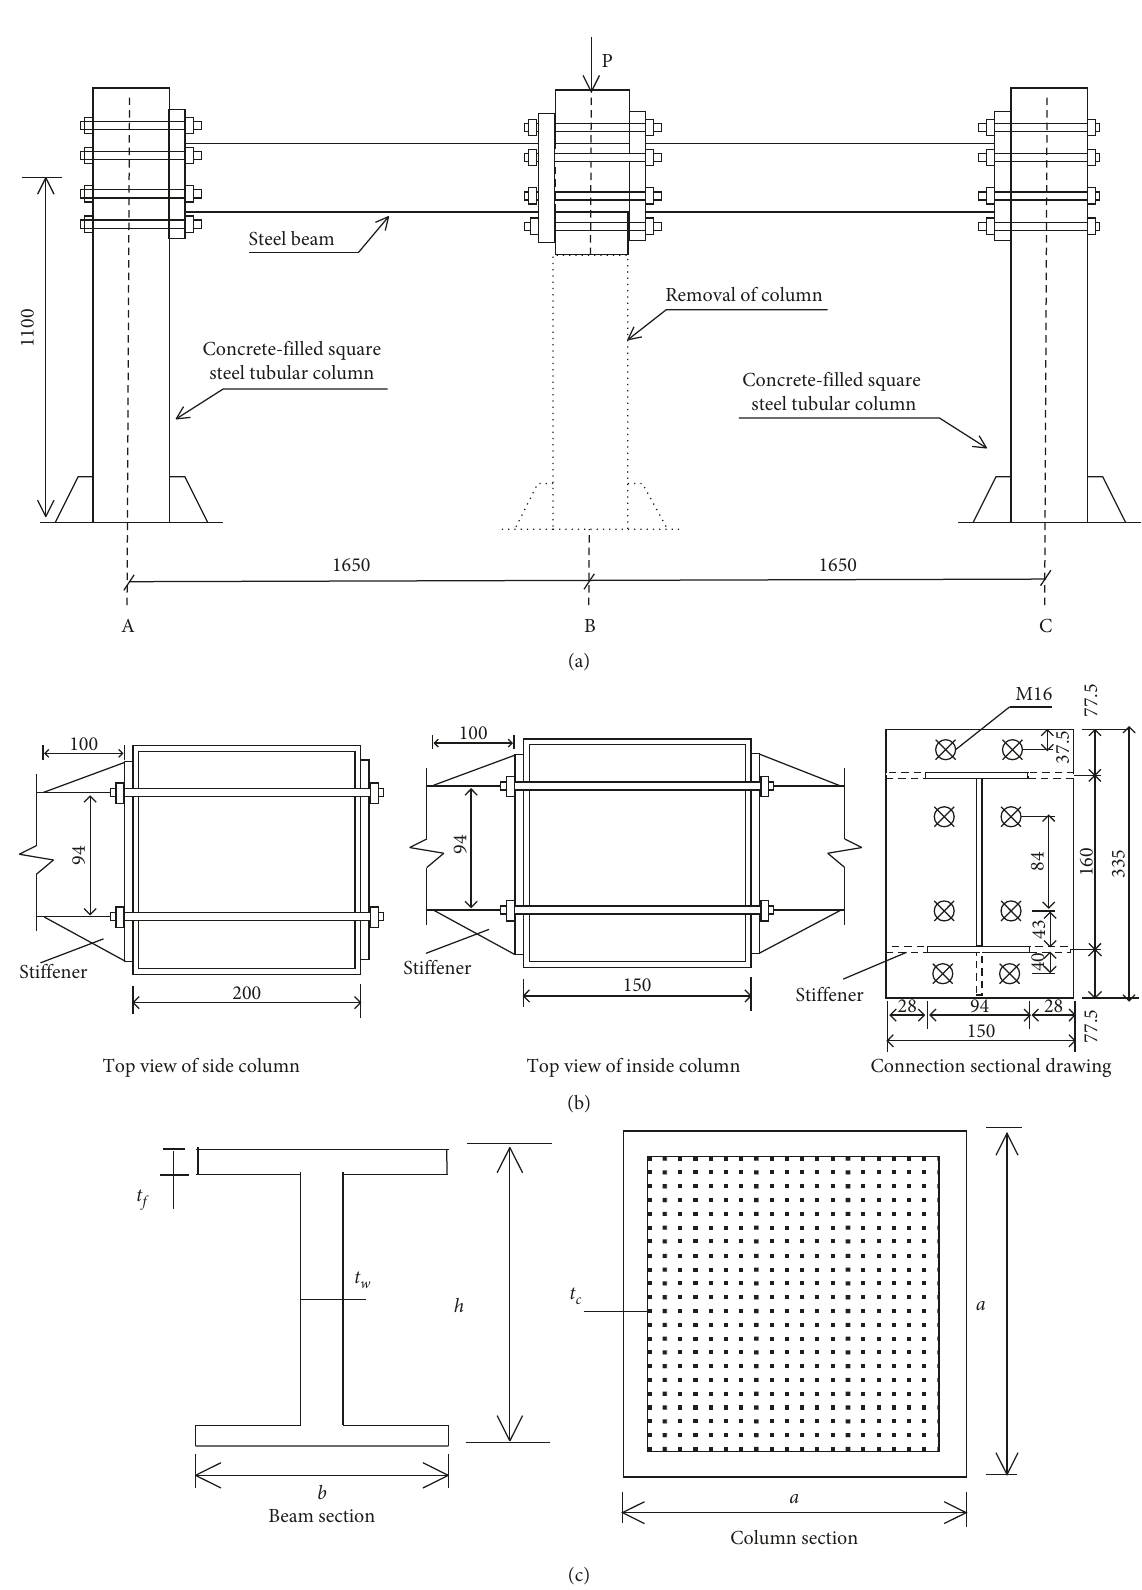
Figure 1: Geometric parameters of the CFSTSBF specimen (unit: mm). (a) Elevation drawing. (b) Connection details. (c) Beam and column sectional geometric